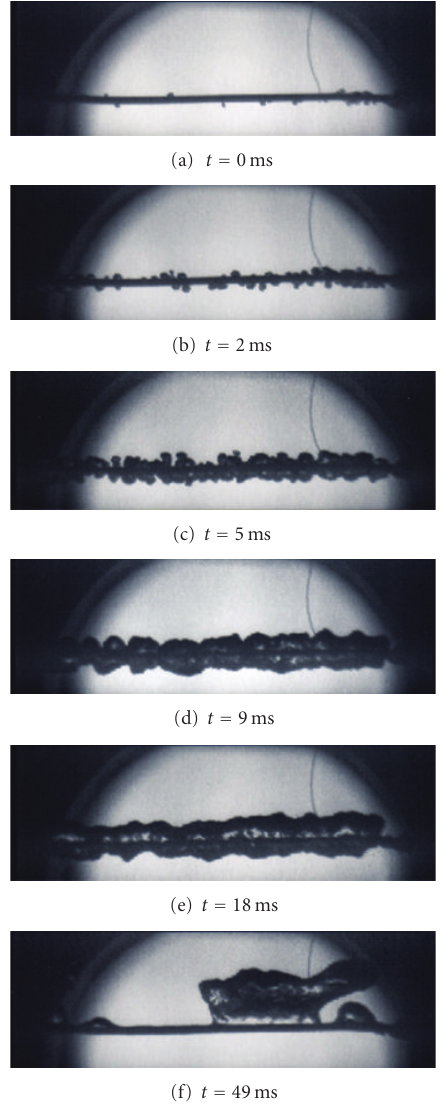
Figure 10: Vapor film behavior during semi-direct transition to film boiling for a period of 0.01 s at atmospheric pressure in saturated